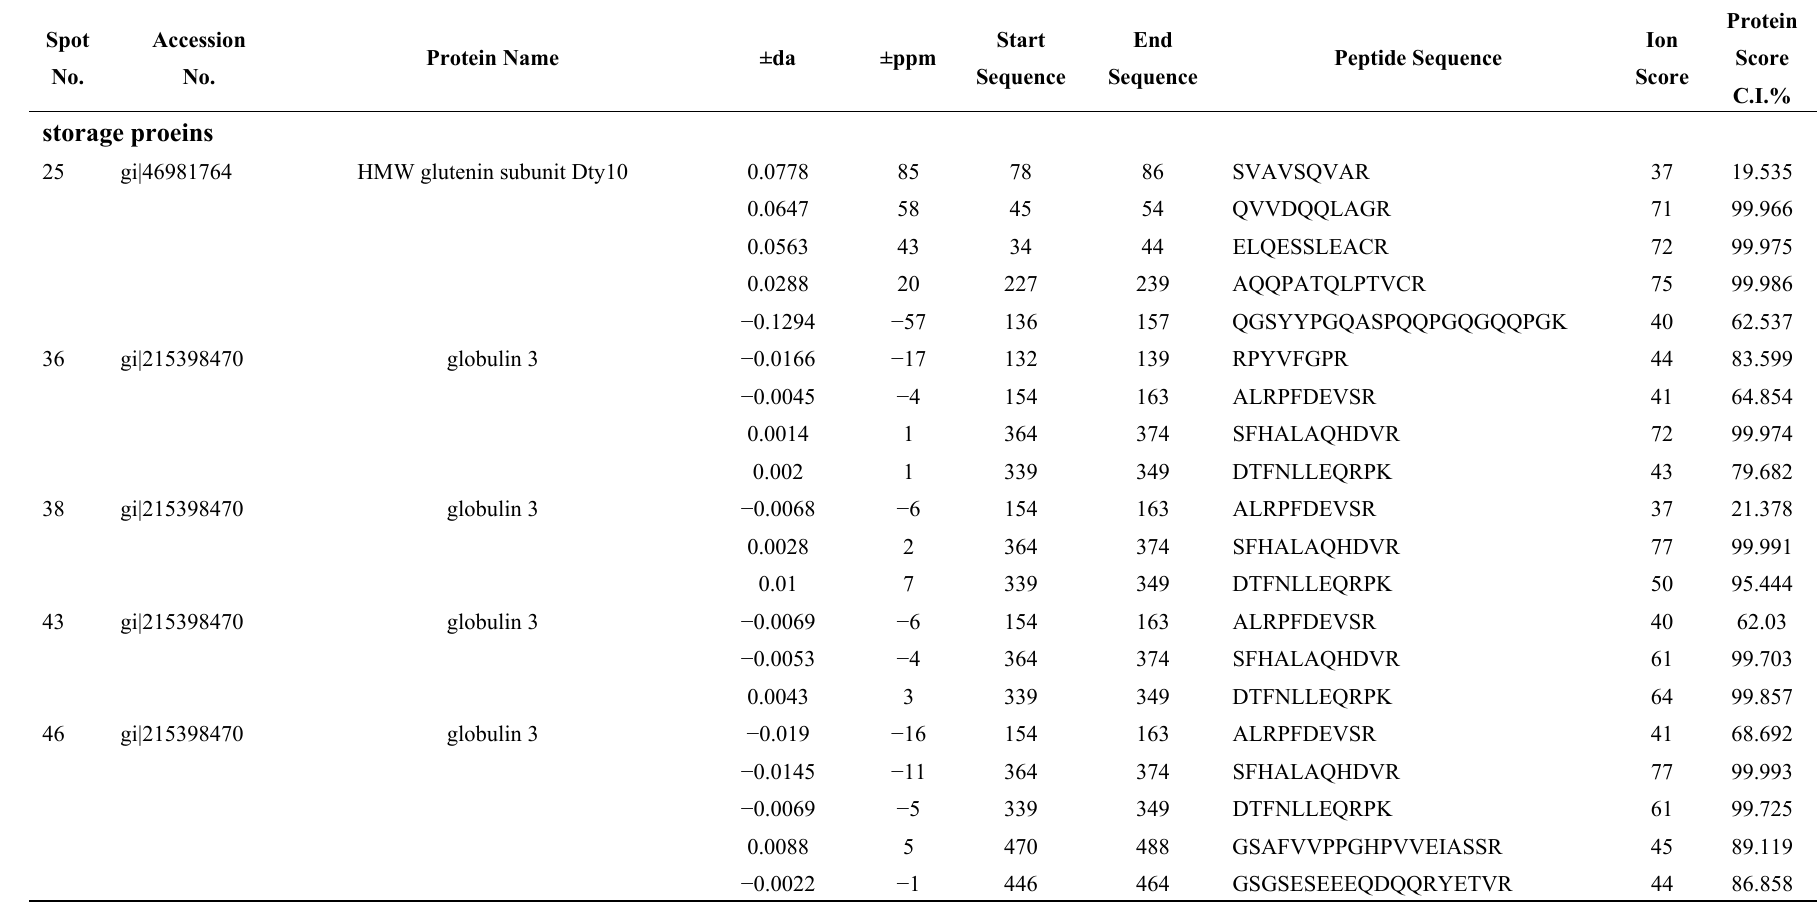
Table 2. The peptide sequences of differentially expressed proteins between CS and 3BS-8 identified by